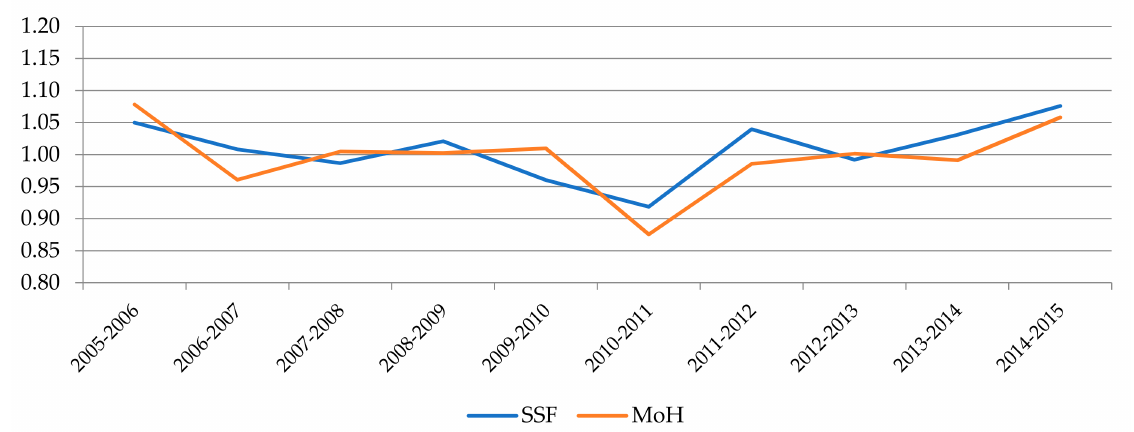
Figure 3. Evolution of EC by type of management.